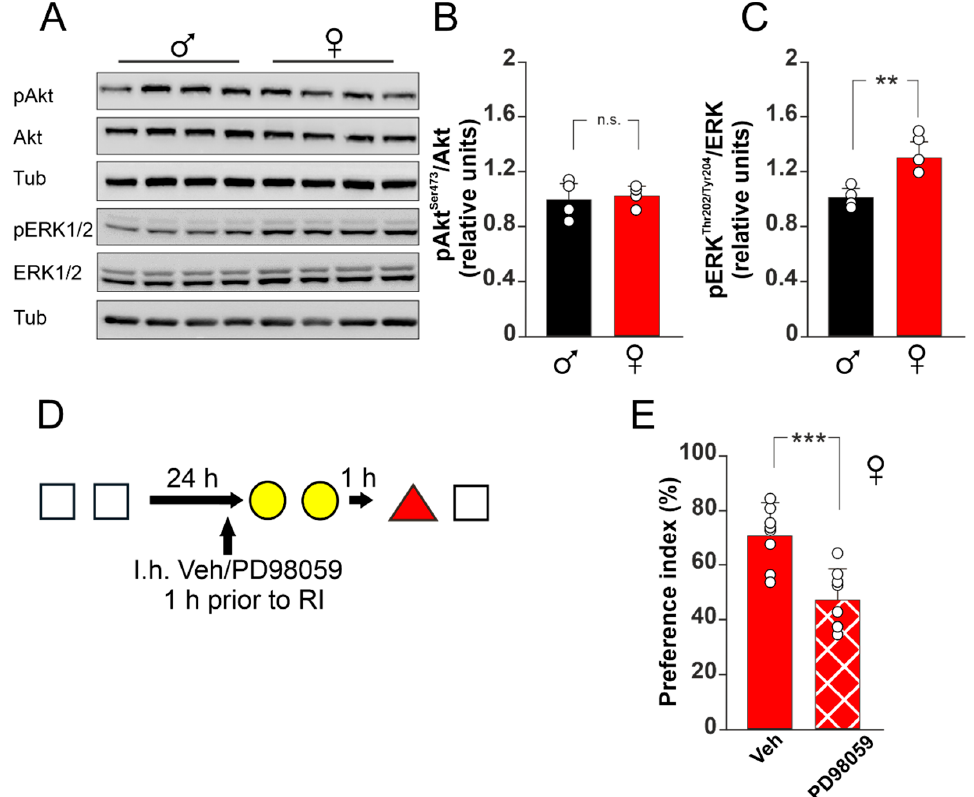
Figure 3. ERK1/2 inactivation leads to RI-induced memory loss in female mice. ( A ): Representative Western blots for Akt and ERK1/2 phosphorylation; white squares represent object 1, yellow circles represent object 2, and red triangle represents object 3. ( B ): Histograms (means ± SD) showing fold induction variation of Akt phosphorylation at S473. One-way ANOVA, F (1;7) = 0.116; p = 0.745. n = 4 for both groups. ( C ): Histograms (means ± SD) showing fold induction variation of ERK1/2 phosphorylation at Thr202/Tyr204. One-way ANOVA, F (1;7) = 16.885; p = 0.006; n = 4 for both groups. ( D ): Schematic representation of experimental protocols including vehicle (Veh) or PD98059 intrahippocampal (I.h.) injections. ( E ): Histograms (means ± SD) showing preference indexes of female mice undergoing the RI paradigm in the presence of vehicle or PD98059. Asterisks indicate statistically significant differences between groups assessed by one-way ANOVA (F (1;14) = 18.368, p < 0.001; n = 8 for both groups). ** p < 0.01; *** p < 0.001; n.s., not significant. All graphs and images were realized using CorelDraw21 (Corel Corporation, Ottawa, Ontario, Canada). Table 3. Exploration time during training, interference, and test, relative to Figure 3. Veh: vehicle; PD98059: MEK inhibitor.